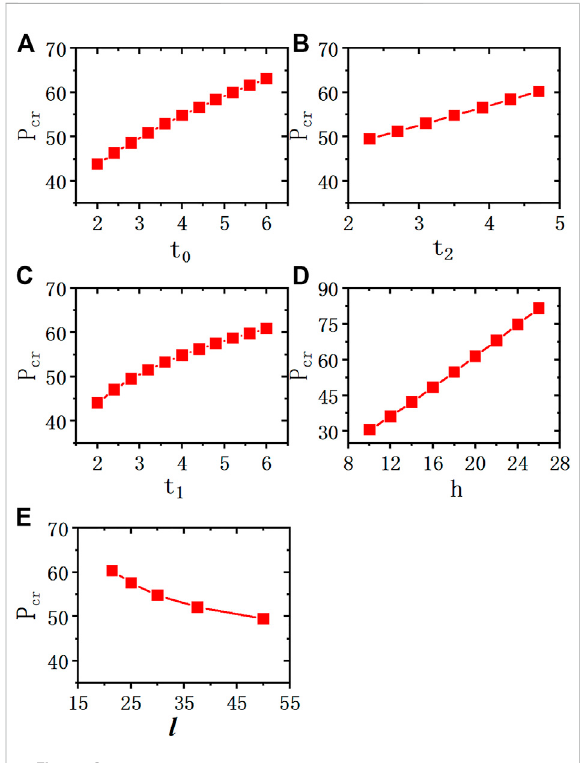
Figure 9 In fl uence of geometrical parameters on critical global buckling load: (A) (Pcr with t 0 ), (B) (Pcr with t 2 ), (C) (Pcr with t 1 ), (D) (Pcr with h), (E) (Pcr with l ).